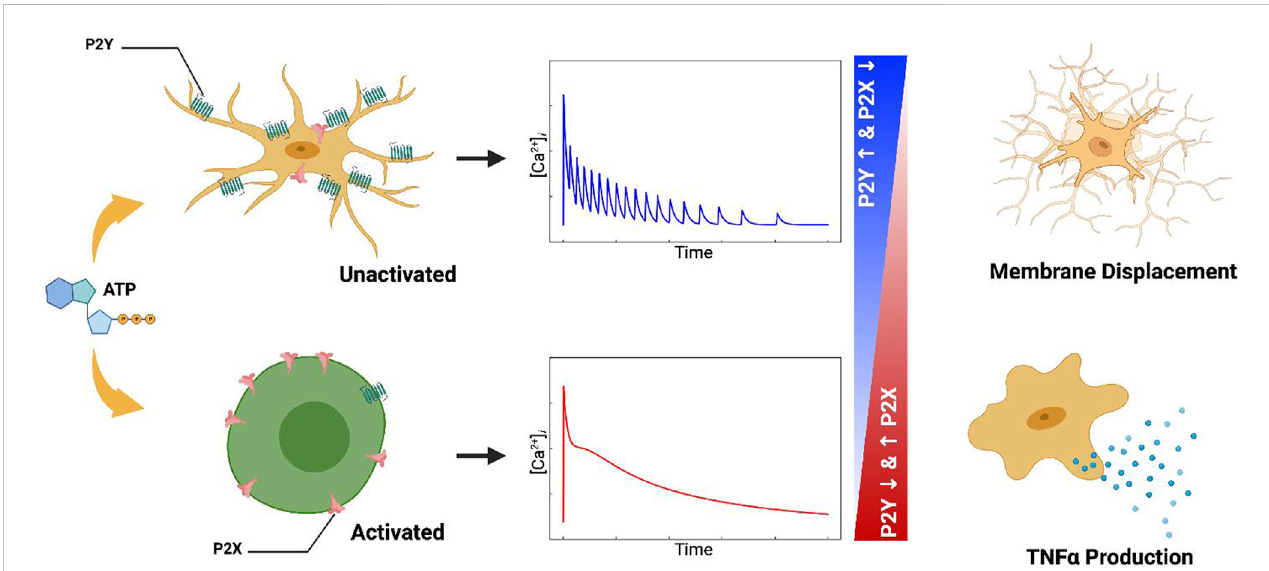
FIGURE 1 Table of Contents Graphic. Schematic of the computational model for ATP triggered P 2 Y and P 2 X receptors expressed in microglia (left column). The computational model predicts cellular responses including intracellular Ca 2+ signals (middle column), migration, and cytokine production (right column) in response to ATP.